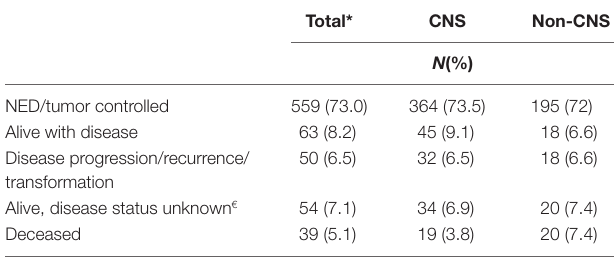
TaBle 4 | Clinical and vital status at last